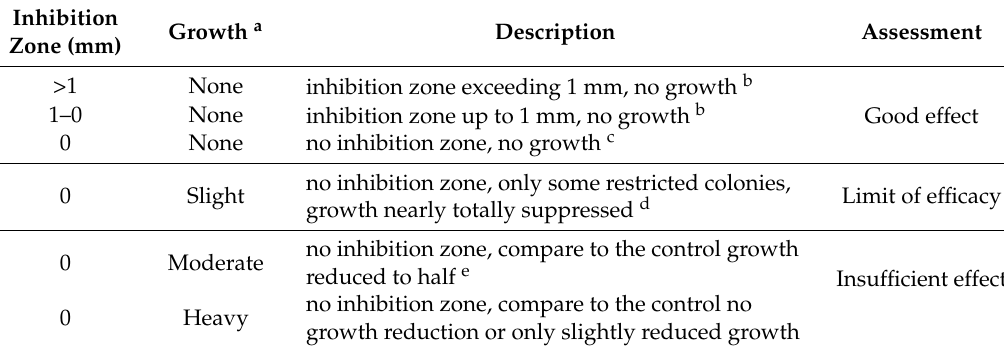
Table 7. Stipulated criteria for defining the effect of an antibacterial